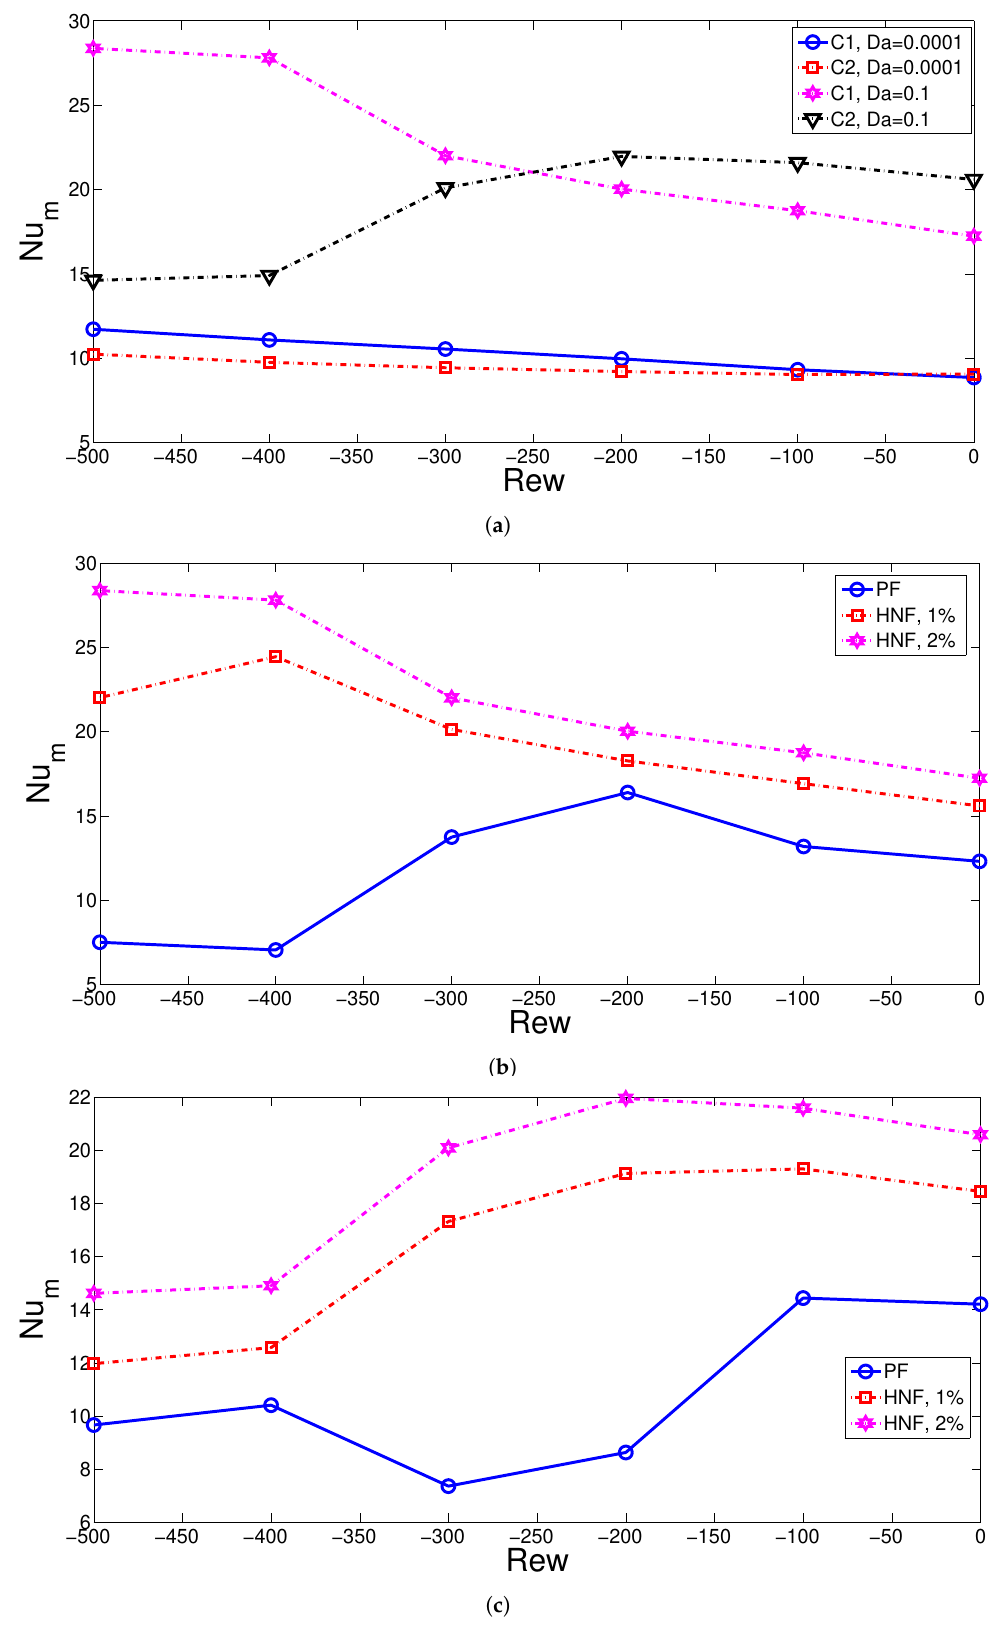
Figure 6. Impacts of Rew on the average Nu variations of hot cylinders C1 and C2 considering different permeability of the cylinders ( a ) and considering different fluids ( b , c ) (Re = 300, sc = 3Rc). ( a ) HNF-2%; ( b ) C1, Da = 0.01; ( c ) C2, Da =